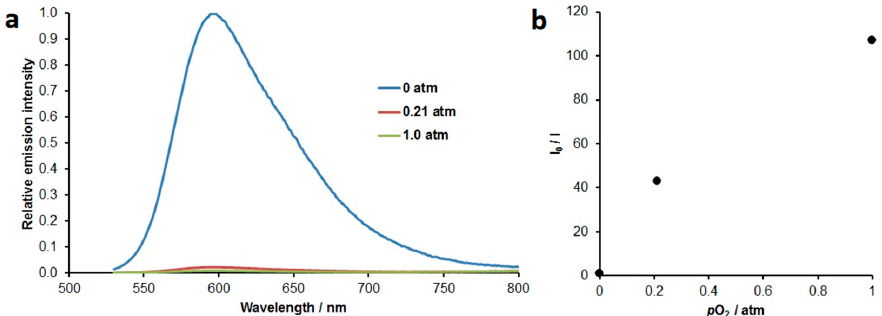
Figure 2. ( a ) Relative oxygen dependent emission spectra for 1 in acetonitrile (normalized for deoxygenated (vacuum) conditions) and ( b ) Stern-Volmer plot ( I 0 and I are the emission intensities at λ max for the degassed solution and solution at the partial pressure of oxygen at which emission is measured respectively).